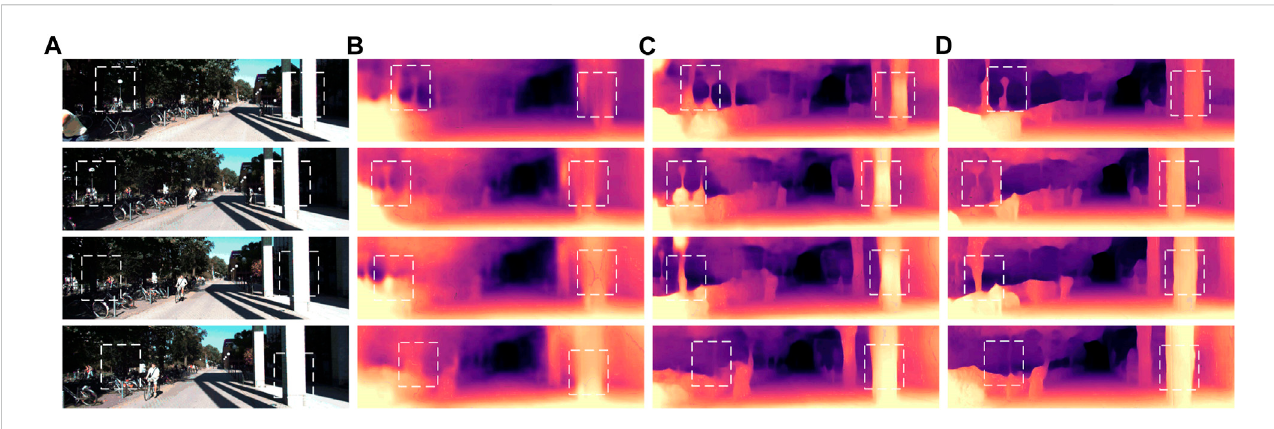
FIGURE 12 Comparativeexperimentalresultsoftheper-pixelminimumreprojectionerrorvisualizedintheKITTIdataset: (A) Thecolorimageinputbythemodel; (B) The depthmap result predictedby Zhouet al.; (C) The depth map predicted bythewhole network structureafter improvement; (D) The depthmap predicted by the whole model after using the minimum reprojection error loss